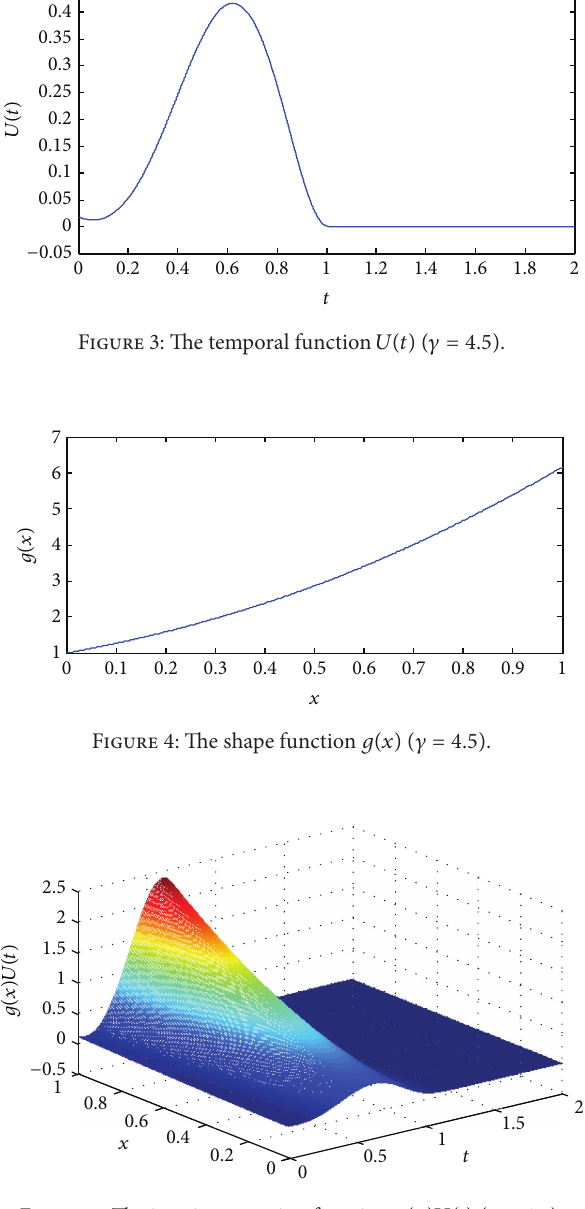
Figure 5: The interior actuation function 𝑔(𝑥)𝑈(𝑡) ( 𝛾 = 4.5 ).